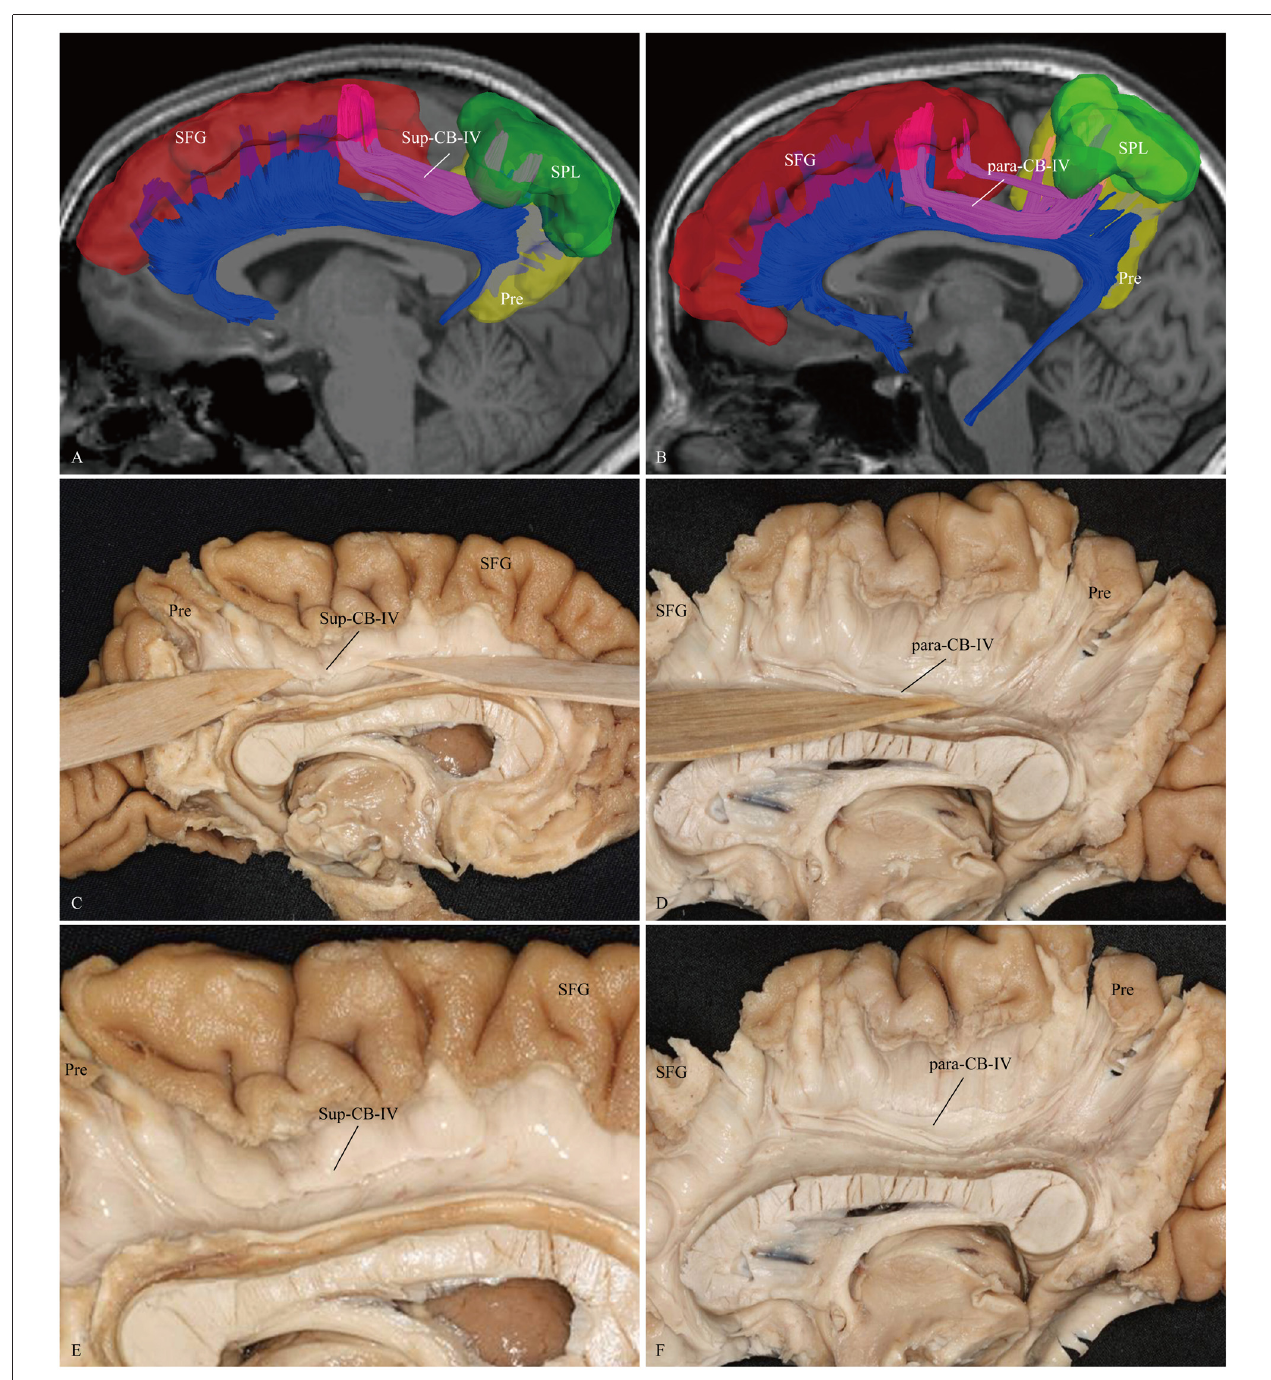
FIGURE 6 | In vivo fiber tractography and fiber microdissection of the CB-IV. The CB-IV is a short and minor tract that connects the SPL and precuneus with the supplementary and premotor areas. (A,C,E) The CB-IV (purple color) can be defined as supra-cingulate location with the other segments (blue color). (B,D,F) The CB-IV (purple color) can be defined as a para-cingulate location with the other segments (blue color). SFG, superior frontal gyrus; SPL, superior parietal lobule; Pre,